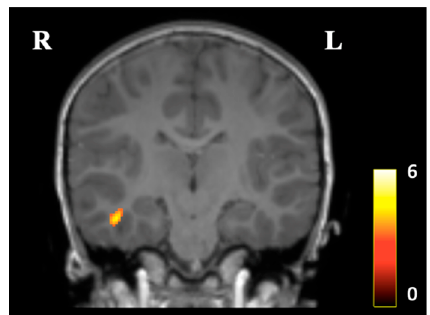
Figure 2. Presentation of the averaged VBM results in children aged approximately six years, in a longitudinal study built on a pilot Randomized Controlled Trial, comparing Cognitive Behavioral Therapy (CBT, n = 8) and Treatment as Usual (TAU, n = 8) for maternal antenatal depression treatment. The image shows increased gray matter concentration in the CBT group, compared to the TAU group, in the right medial temporal area at cluster level p < 0.05 uncorrected. The colored bar refers to Student’s t